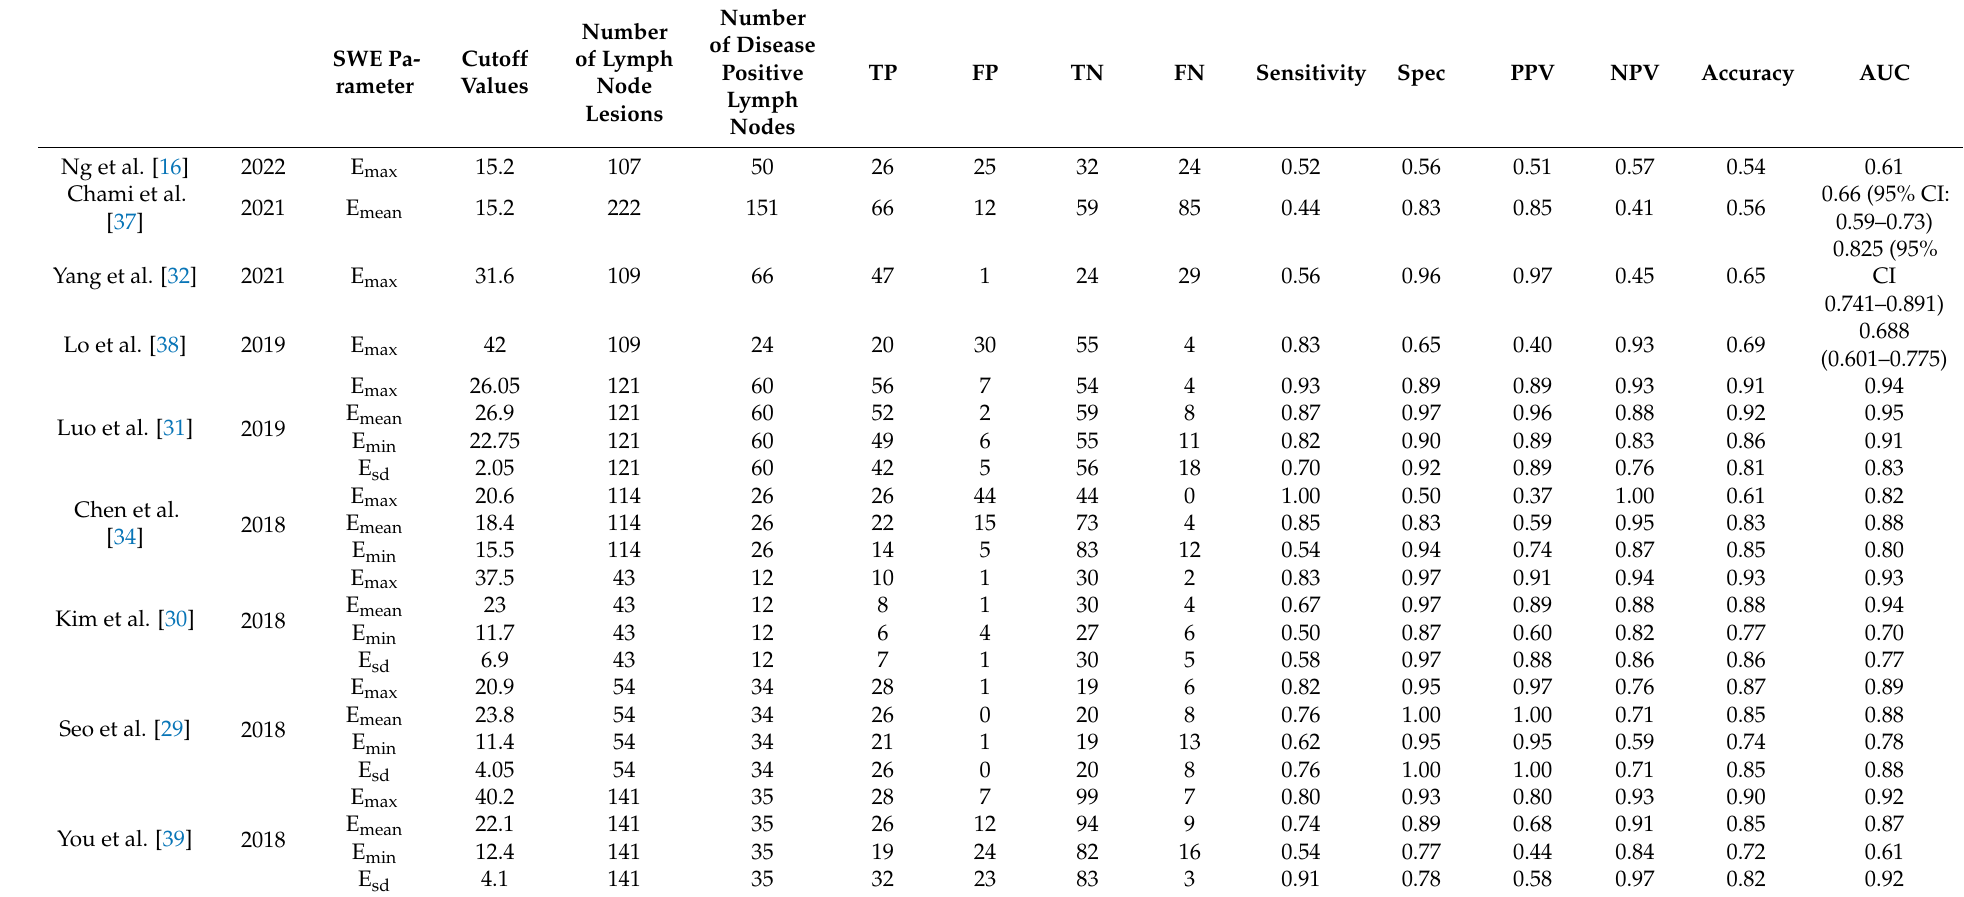
Table 2. Statistical characteristics of included